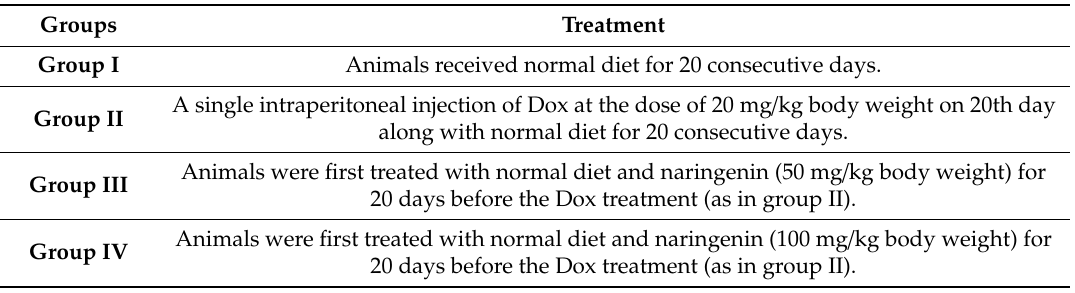
Table 1. Tabular representation of experimental